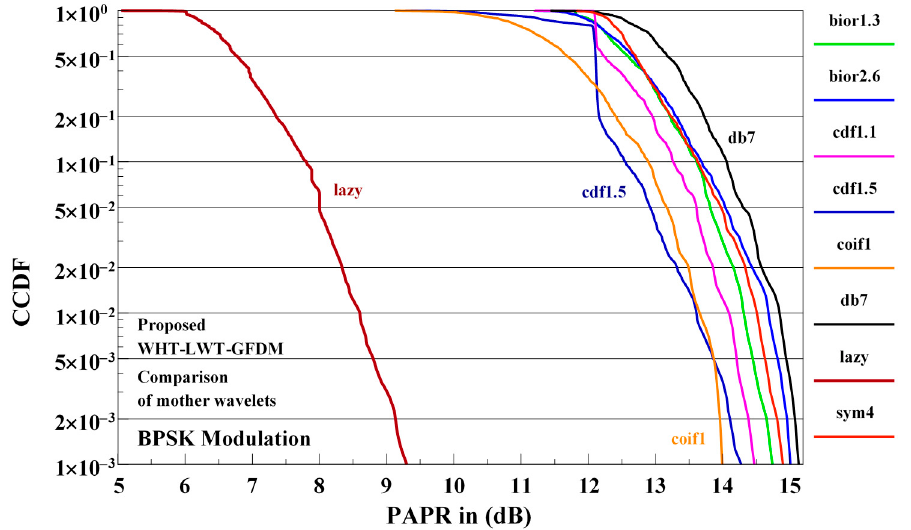
Figure 9. The effects of the different mother wavelets on PAPR performance of proposed WHT-LWT-GFDM waveform for BPSK modulation.